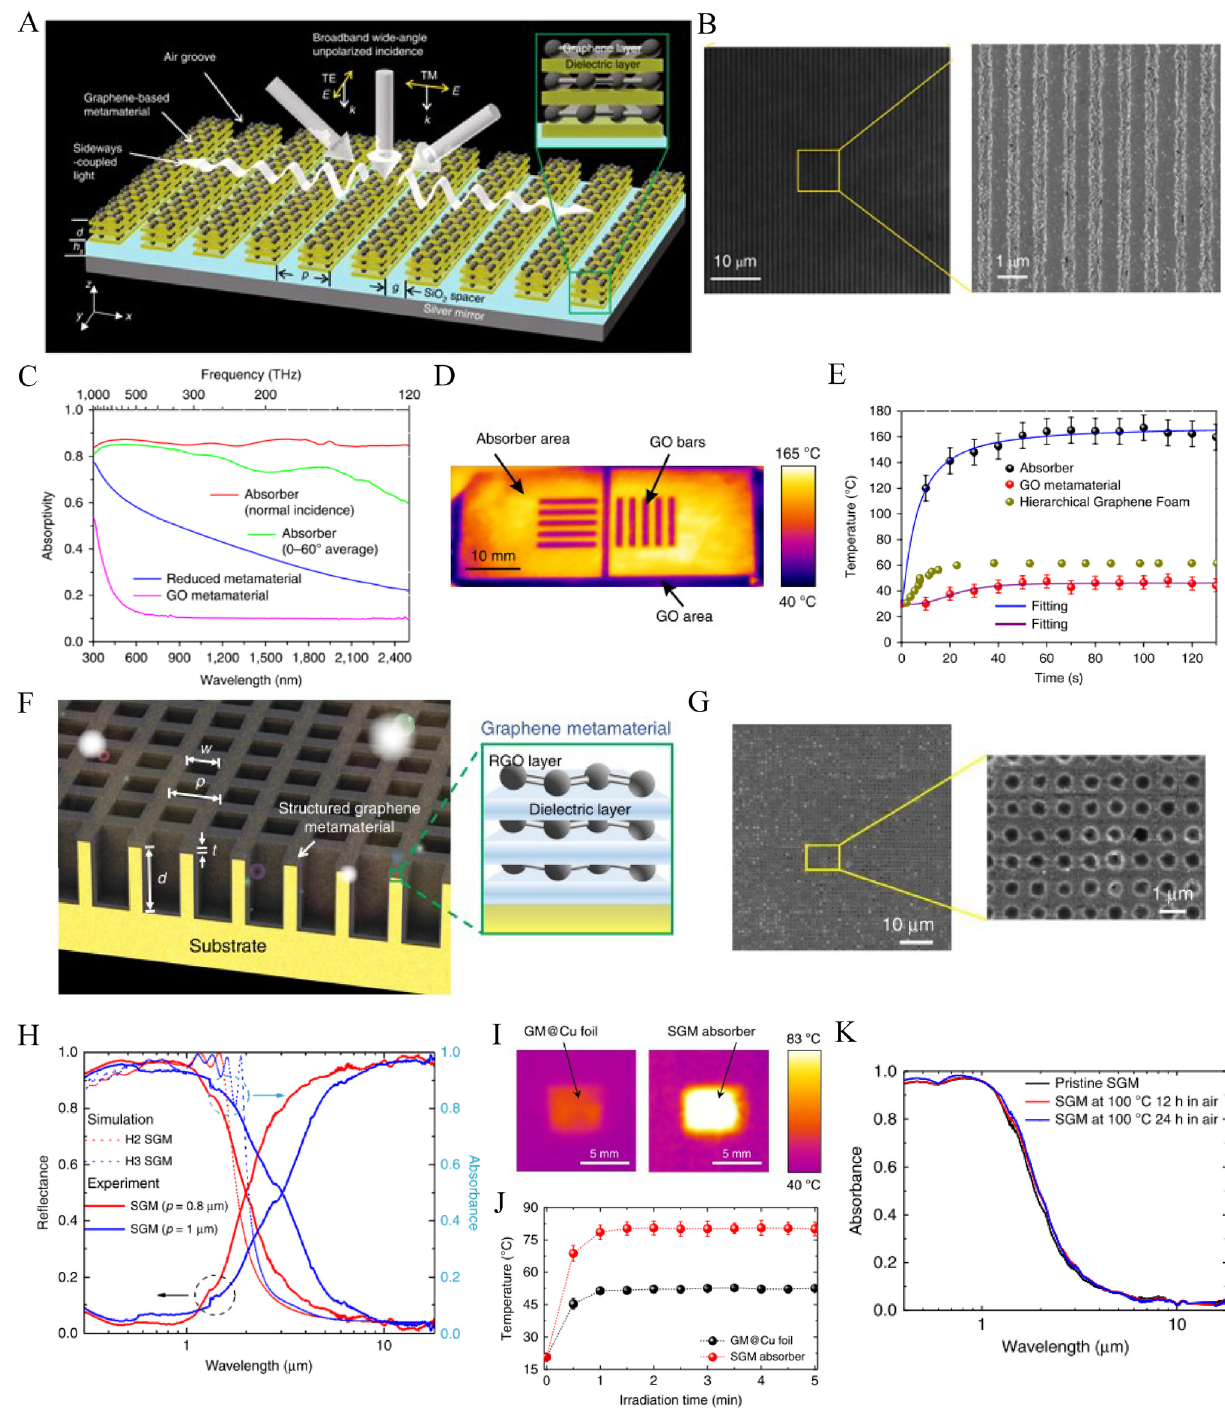
Figure16: (A)Schematicrepresentation,(B)top-viewSEMimages,and(C)measuredabsorptionspectraofthegraphenegratingmetamaterial absorber. (D) Thermal image of the graphene grating metamaterial absorber under illumination of natural sunlight. (E) Temperatures of the graphene grating metamaterial absorber after 130 s of sunlight illumination [101]. Copyright 2019, Springer Nature. (F) Schematic representation and (G) top-view SEM images of the SGM absorber. (H) Simulated and measured absorption spectra of the SGM absorber with different structural parameters. (I) Thermal image of the SGM absorber under illumination of arti fi cial sunlight in an open environment. (J) Temperatures of the SGM absorber after 5 min of illumination. (K) Measured absorption spectra of the SGM absorber before and